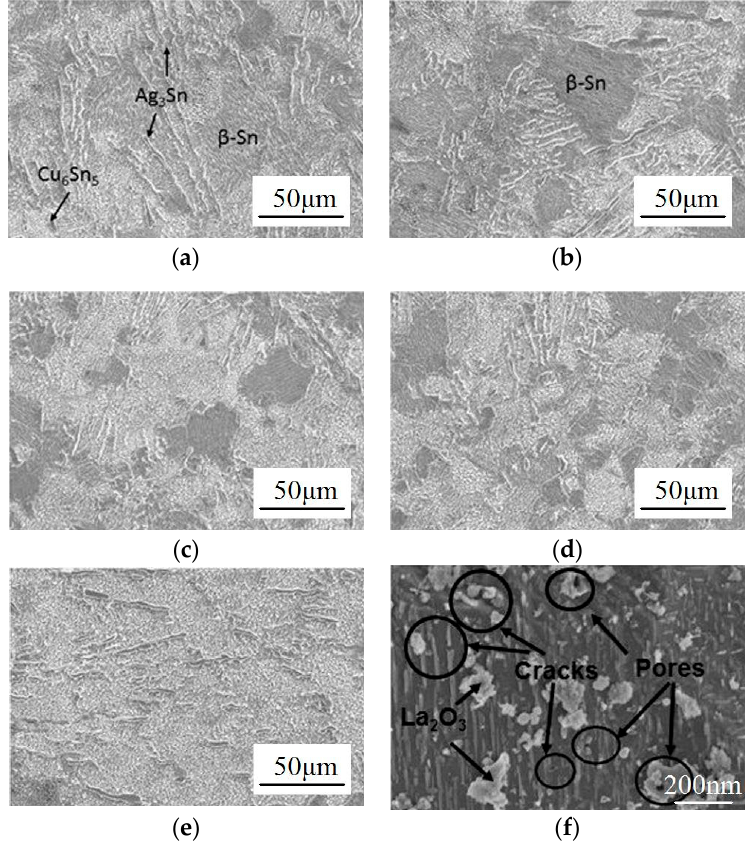
Figure 1. Field emission scanning electron microscope (FESEM) image of SnAgCu–nano La 2 O 3 composite solder: ( a ) 0% La 2 O 3 ; ( b ) 0.01% La 2 O 3 ; ( c ) 0.03% La 2 O 3 ; ( d ) 0.05% La 2 O 3 ; ( e ) 0.1% La 2 O 3 ; ( f ) high-resolution image of (e) [23].